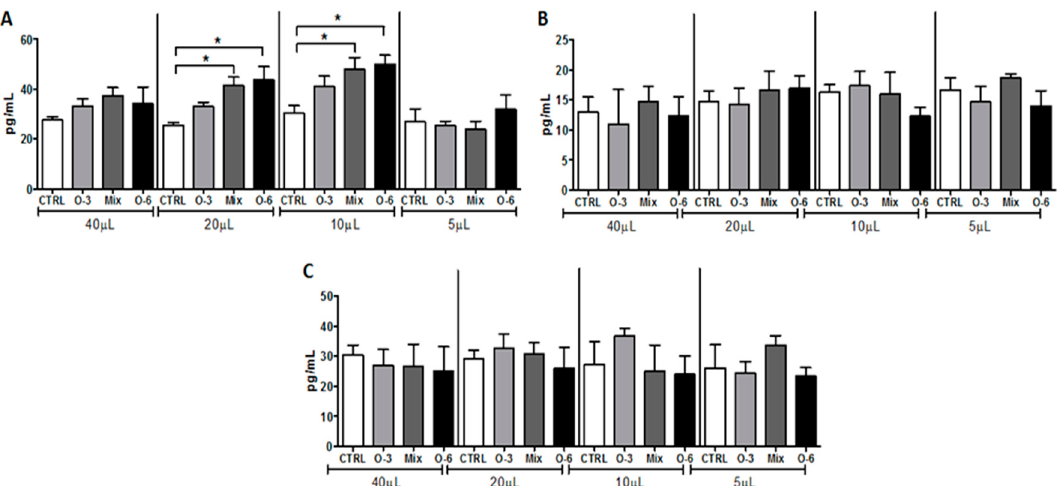
Figure 5. Determination of cytokines in melanoma cell culture. B16F10 cells were cultured with di ff erent concentrations (40, 20, 10, and 5 µ L) of fish oil rich in omega-3 or soybean oil rich in omega-6 or a mixture of these oils in a ratio of 1:1 for 48 h to determine the concentration of IL-10 ( A ), IL-6 ( B ), and CXCL1 ( C ) levels. The risk value α was set at 5% ( p < 0.05). * p < 0.05.